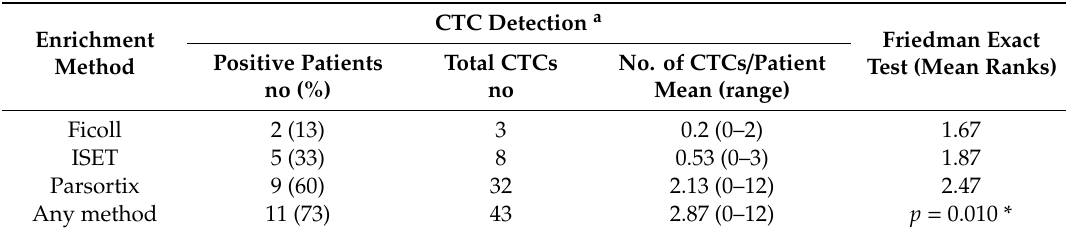
Table 1. Frequency of CTC detection in patients with non-small cell lung cancer (NSCLC) using manual and automated